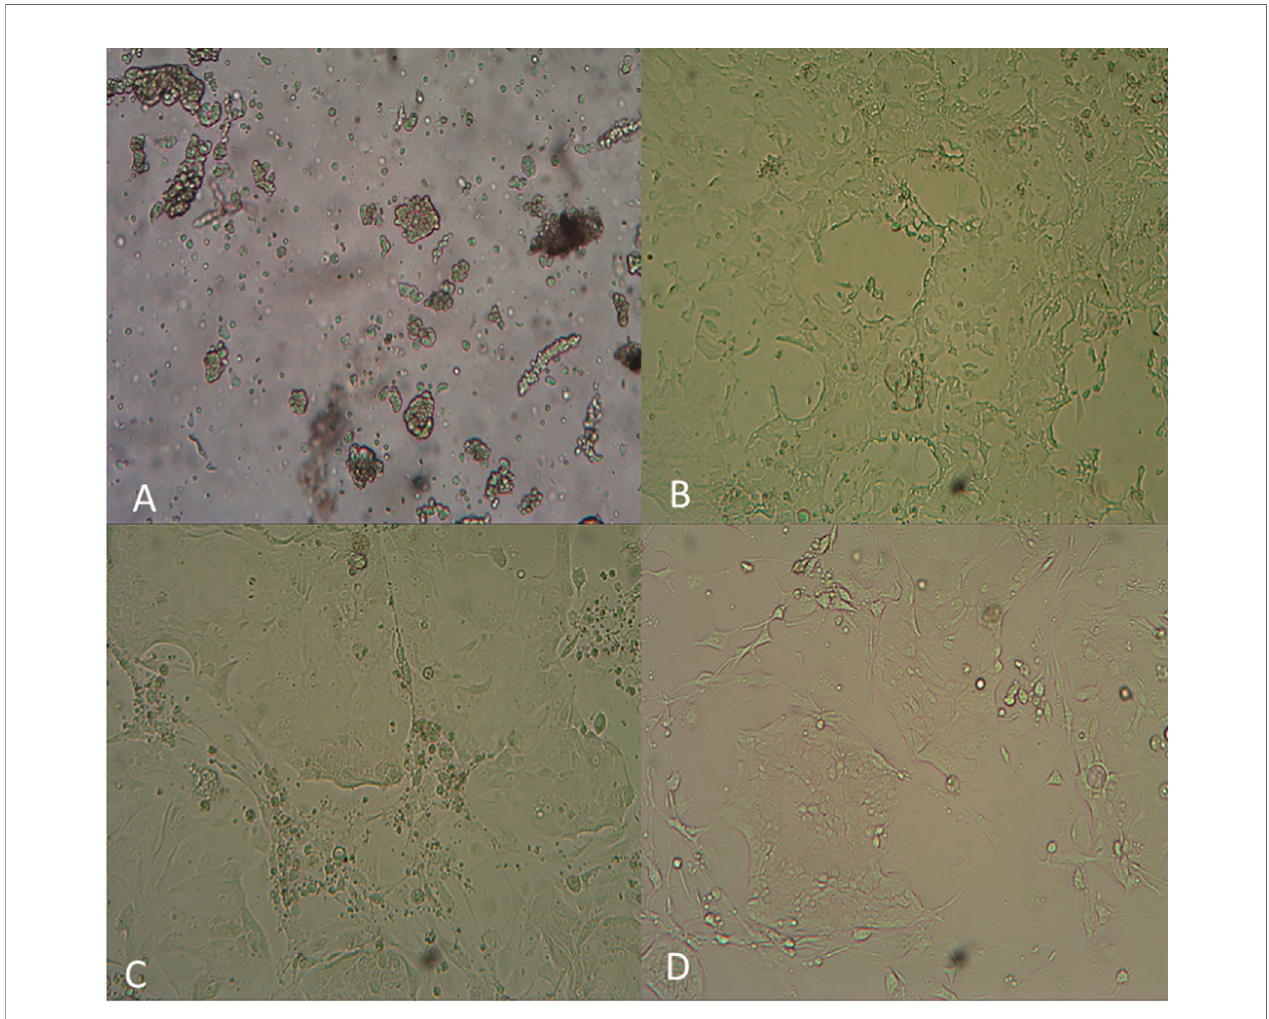
FIGURE 4 | Photos of the GC primary tumor cell bank generated using the i-CR system. (A) Cell digestion for 30 minutes; (B) Cell culture for 5 days; (C) Cell culture for 9 days; (D) Cell culture for 15